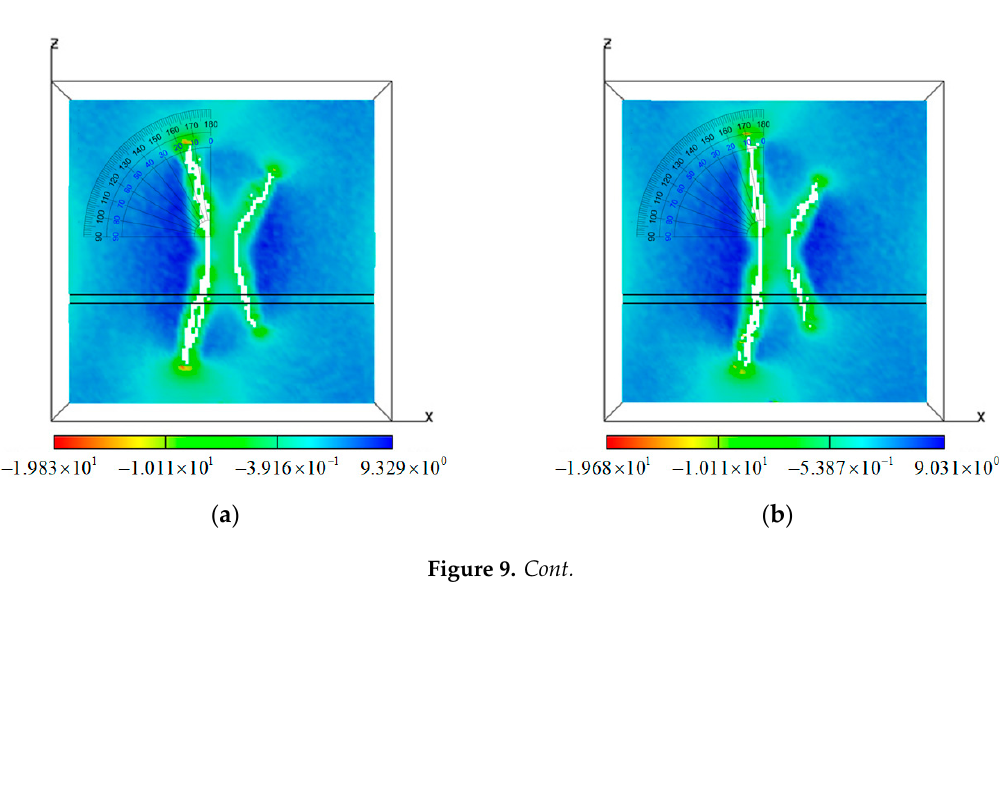
Figure 8. The breakdown pressure/time and reopening pressure/time of fractures in models with different interlayer Young’s modulus and